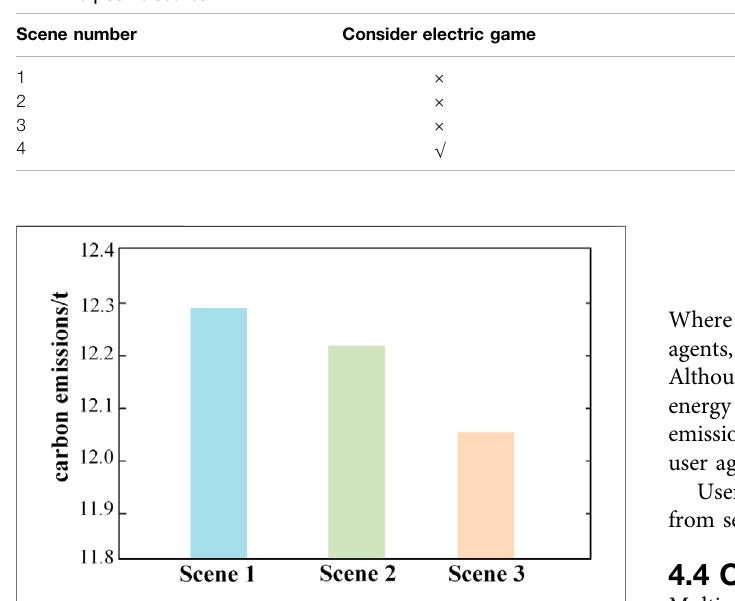
FIGURE 7 | Comparison of carbon